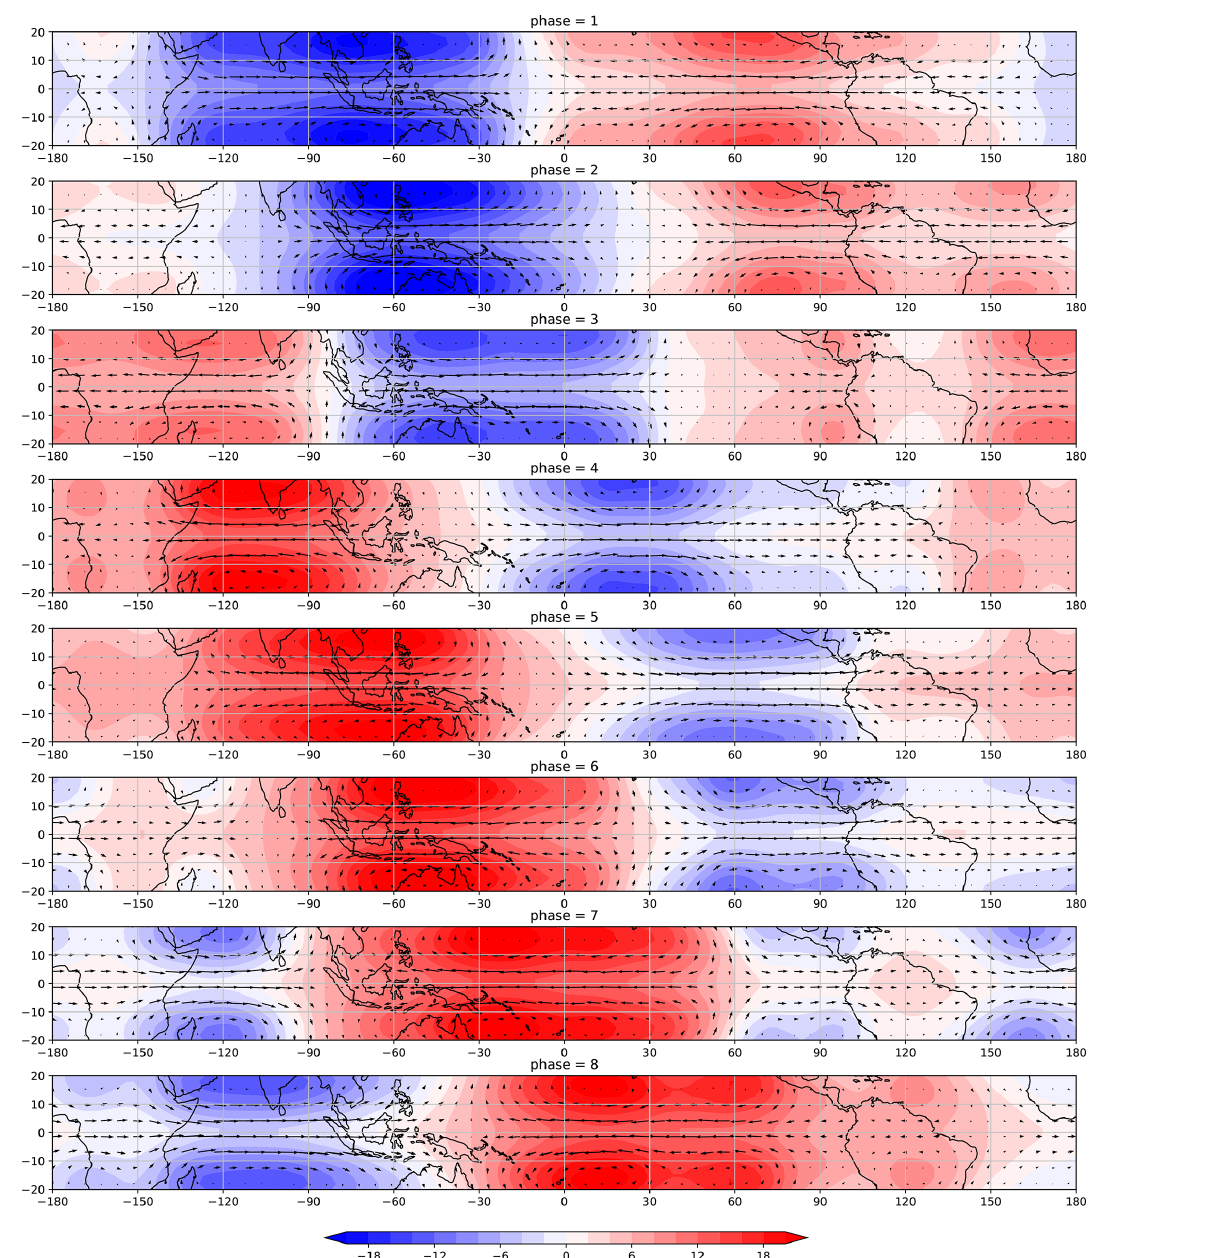
Figure 10. Reconstruction at 200Mb of the velocity and geopotential height fields associated with ROT modes with (positive stratospheric zonal wind) SZW30 +